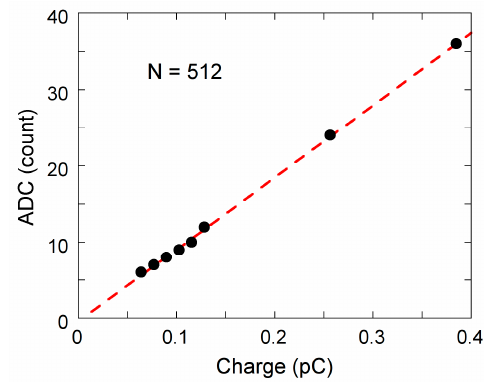
Figure 11. The results obtained for ADC counts without performing the “zero measurement” in the range of tenths of pC. Each data point (black dots) is the average value of 512 input pulses. The dotted line represents linear best fit of experimental data. A non-linearity up to 5% is